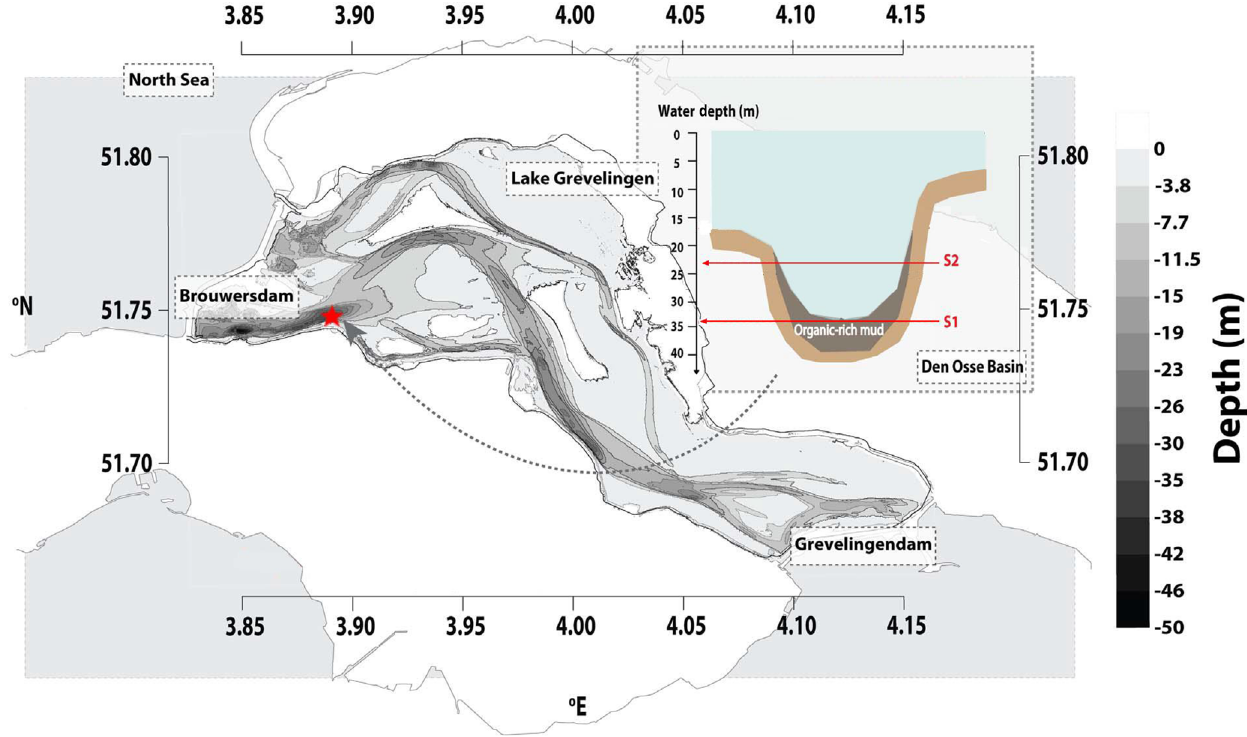
Figure 1. Map of Lake Grevelingen showing the location of the two sampled stations in the Den Osse Basin (red star). The transversal section of the Den Osse Basin (top right) shows the depth at which station 1 (S1) and station 2 (S2) were sampled (34 and 23m depth, respectively). This figure was modified from Sulu-Gambari et al.